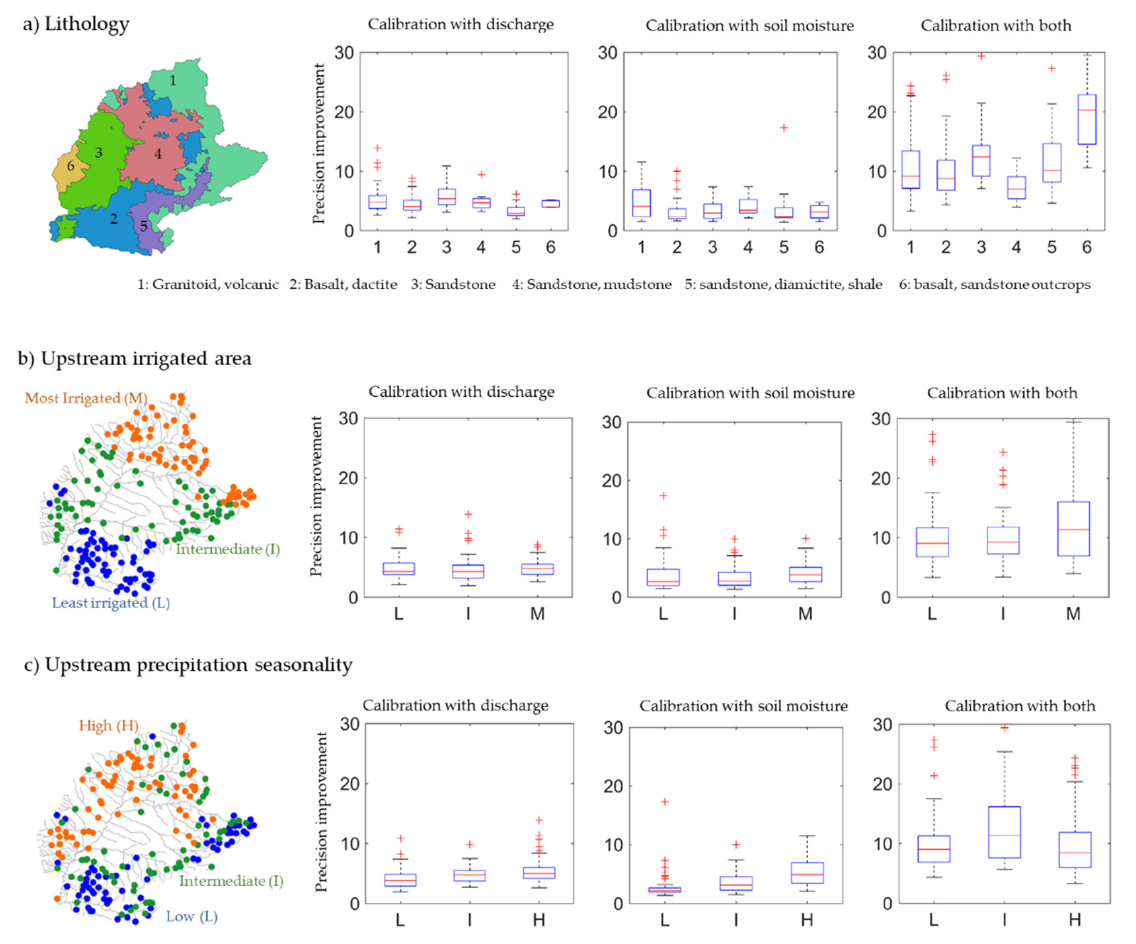
Figure 7. Performance precision improvements according to ( a ) geological characteristics (six lithology classes), ( b ) water use for agriculture (irrigation areas, divided into three groups of irrigation areas—most irrigated, intermediate, and least irrigated upstream areas), and ( c ) precipitation characteristics (seasonality, divided into three groups—high, intermediate and low seasonality in upstream areas). In the second and third rows of maps, each point refers to one of the 136 gauge locations used for the model calibration. Each boxplot refers to a different class (geological characteristics, irrigation areas and precipitation seasonality).